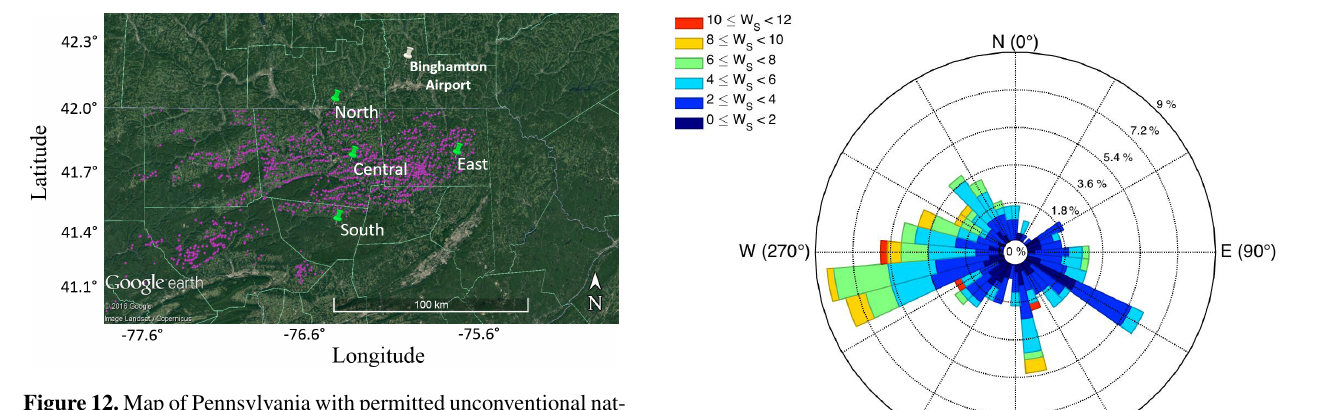
Figure 12. Map of Pennsylvania with permitted unconventional nat- ural gas wells (magenta dots) and network of towers with methane and stable isotope analyzers (Picarro G2132-i). The east and south towers were also equipped with NOAA flask sampling systems. The Binghamton airport is also indicated. Figure 13. Wind rose for surface station at Binghamton, NY, air-